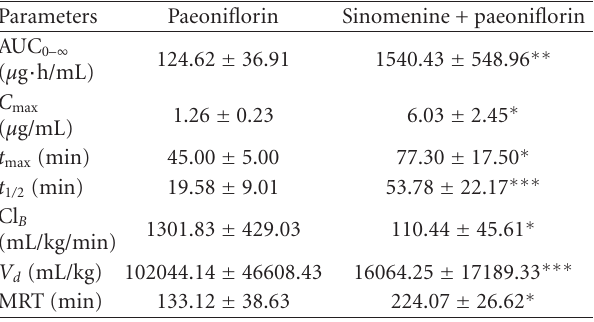
Table 28: Pharmacokinetic parameters of paeoniflorin (150mg/kg) and in combination with sinomenine (90mg/kg) after oral admin- istration in rats